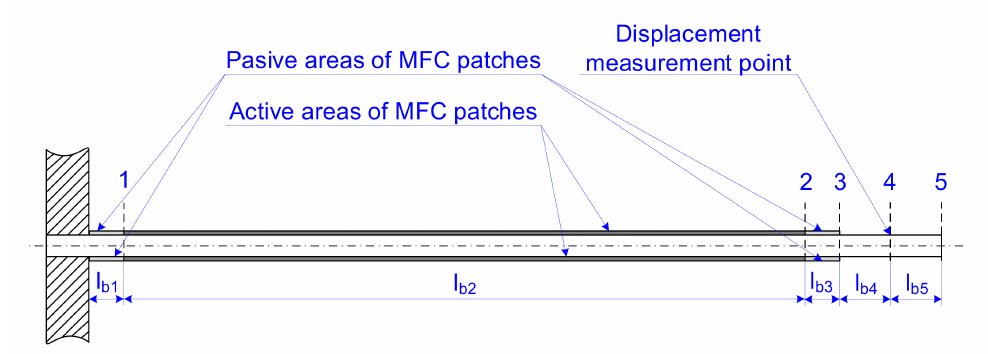
Figure 1. Division of bimorph beam structure into five